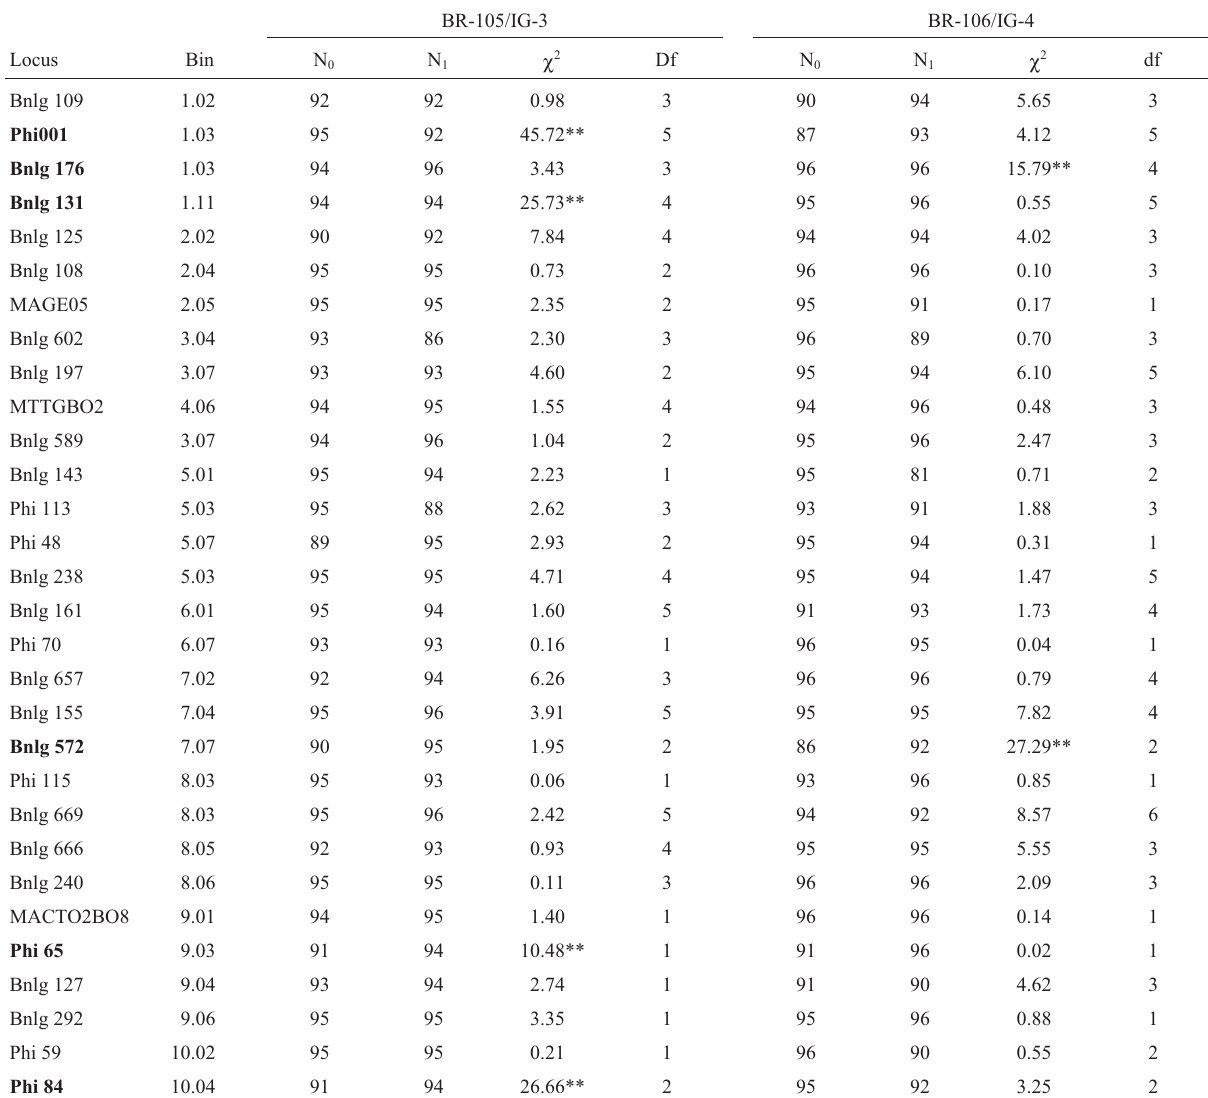
Table 3 - Neutrality test for changes in allele frequencies after one cycle of RRS in the BR-105 and BR-106 maize